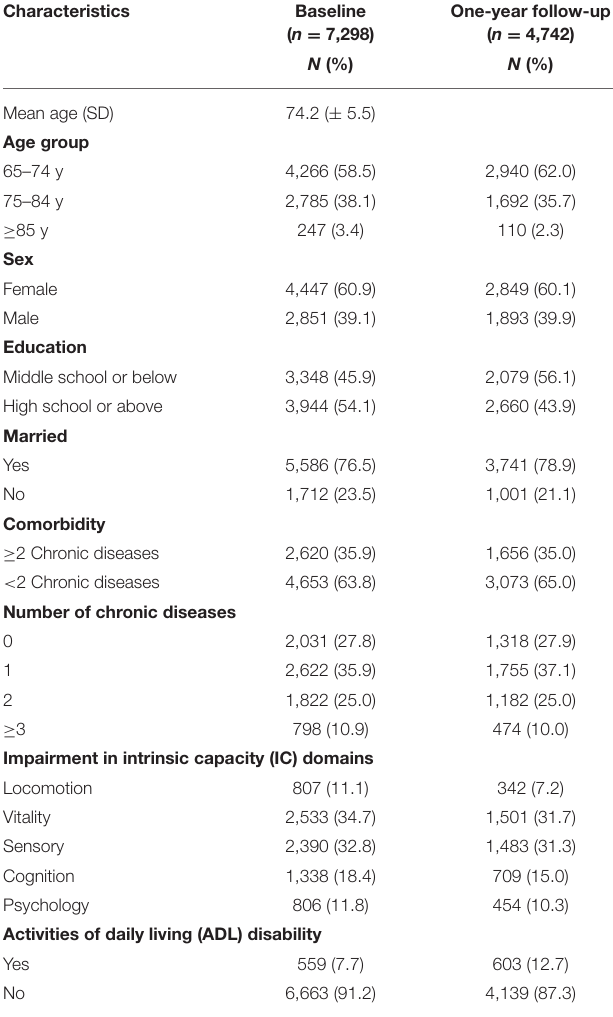
TABLE 1 | Characteristics of the study participants at baseline.